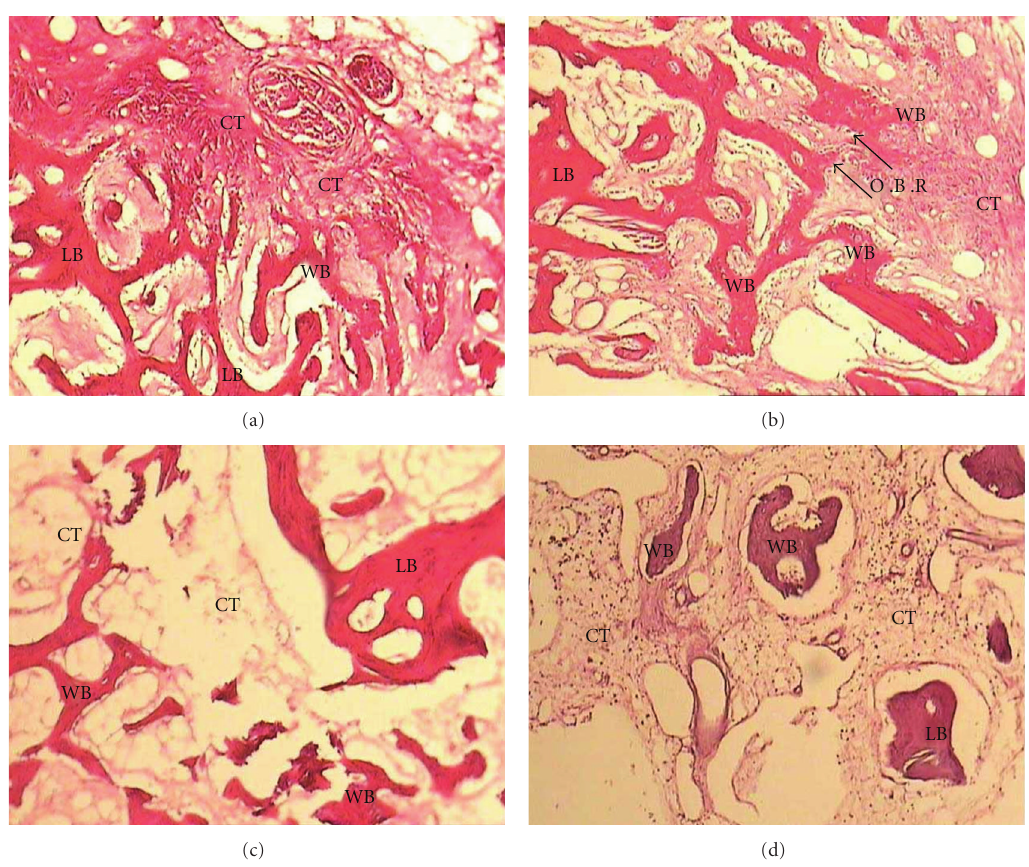
Figure 2: Histological views of new bone formation with hematoxylin-eosin staining (magnification × 100). (a) GBR group; (b) EMD/BC without membrane; (c) EMD/BC with membrane; (d) control group. CT: connective tissue, LB: lamellar bone, WB: woven bone, OBR: osteoblastic rim. Table 1: Mean percentage ( ± SDs) of tissue areas for each experimental group. Tissue Experimental group